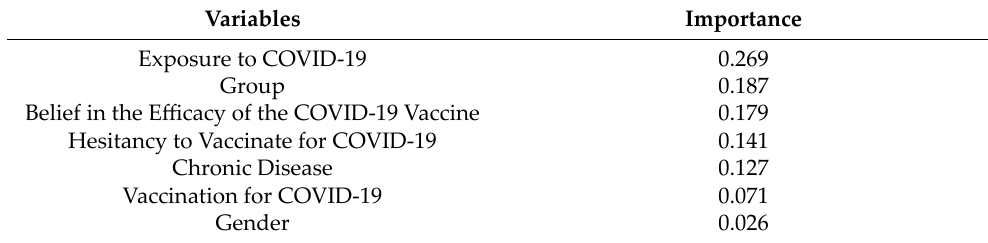
Table 8. Variable importance values obtained from the MLP model for DASS‑21 total.